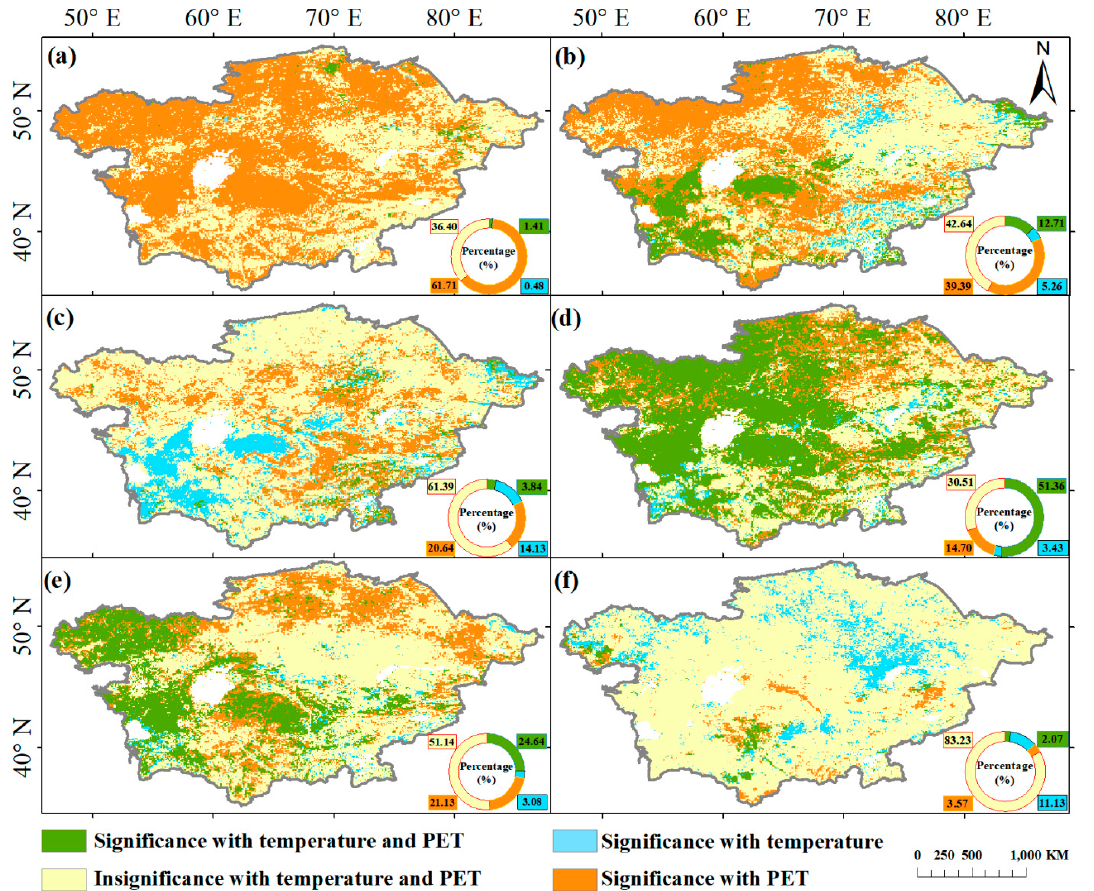
Figure 3. Spatial distribution of significant correlations between the annual ( a ) and growing season ( b ) scales, and the spring ( c ), summer ( d ), autumn ( e ), and winter ( f ) NDVIs and heat conditions in Central Asia during the period 1982 to 2015.